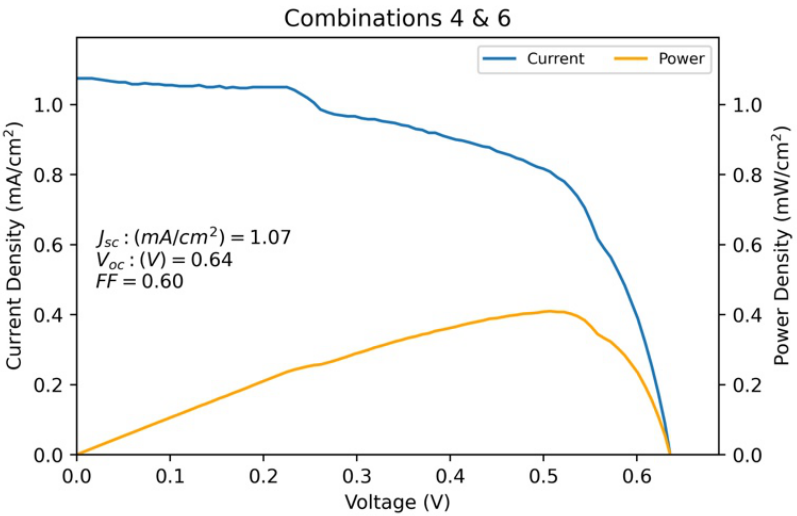
Figure 9. Optimized combinations 4 and 6, with an efficiency of 0.41%.